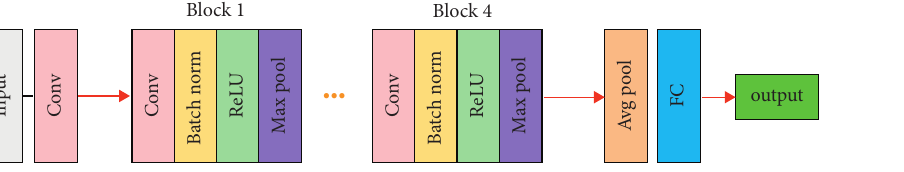
Figure 3: The detailed structure of